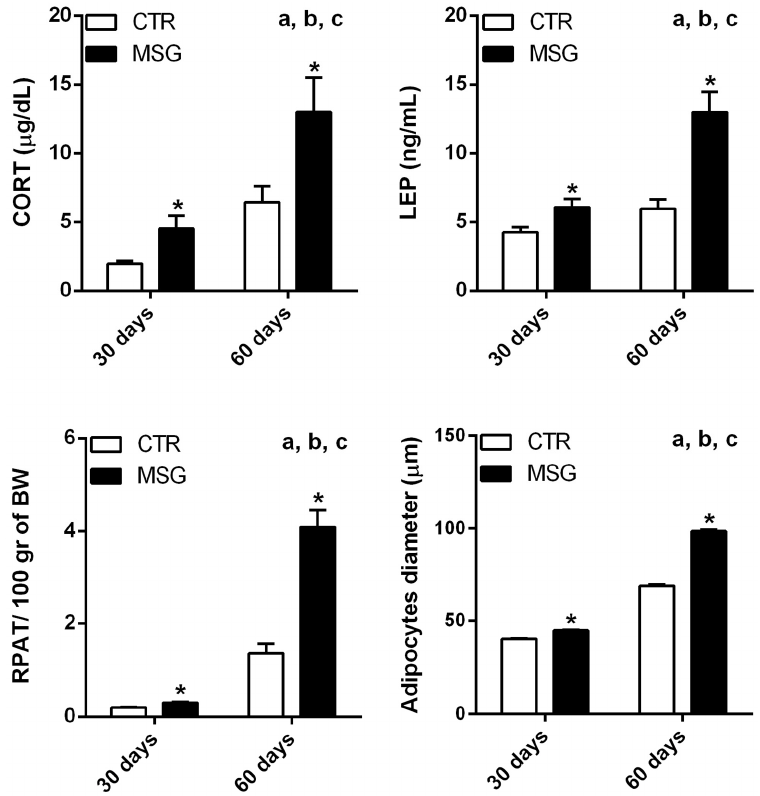
Figure 1. Comparison of hormone levels and retroperitoneal adipose tissue (RPAT) parameters from CTR and MSG rats. Corticosterone (CORT) and leptin (LEP) plasma levels; RPAT/100 g of BW and RPAT adipocyte size from rats at 30 and 60 days of age. Values are means ± SEM. * p < 0.05 vs. CTR values for similar ages. Two-way ANOVA: a those parameters significantly affected by age; b those significantly affected by treatment; c a significant synergic effect of MSG treatment and